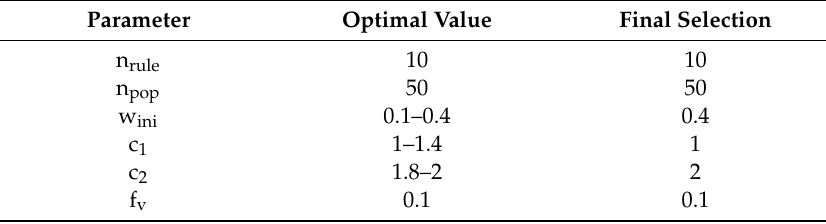
Table 4. Parameters used as optimum.